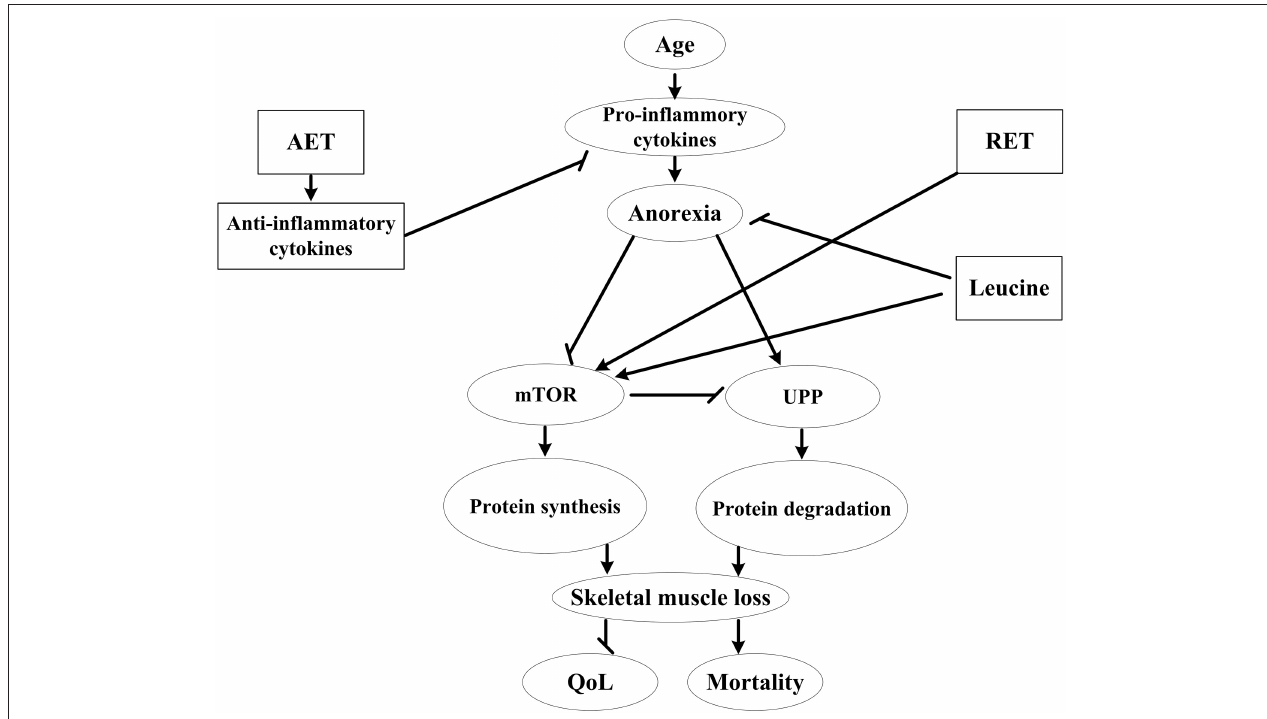
FIGURE 1 | Effects of aerobic and resistance exercise training combined with leucine supplementation in sarcopenia. AET, aerobic exercise training; RET, resistance exercise training; mTOR, mammalian target of rapamycin; UPP, ubiquitin-proteasome pathway; QoL, quality of life; activate;